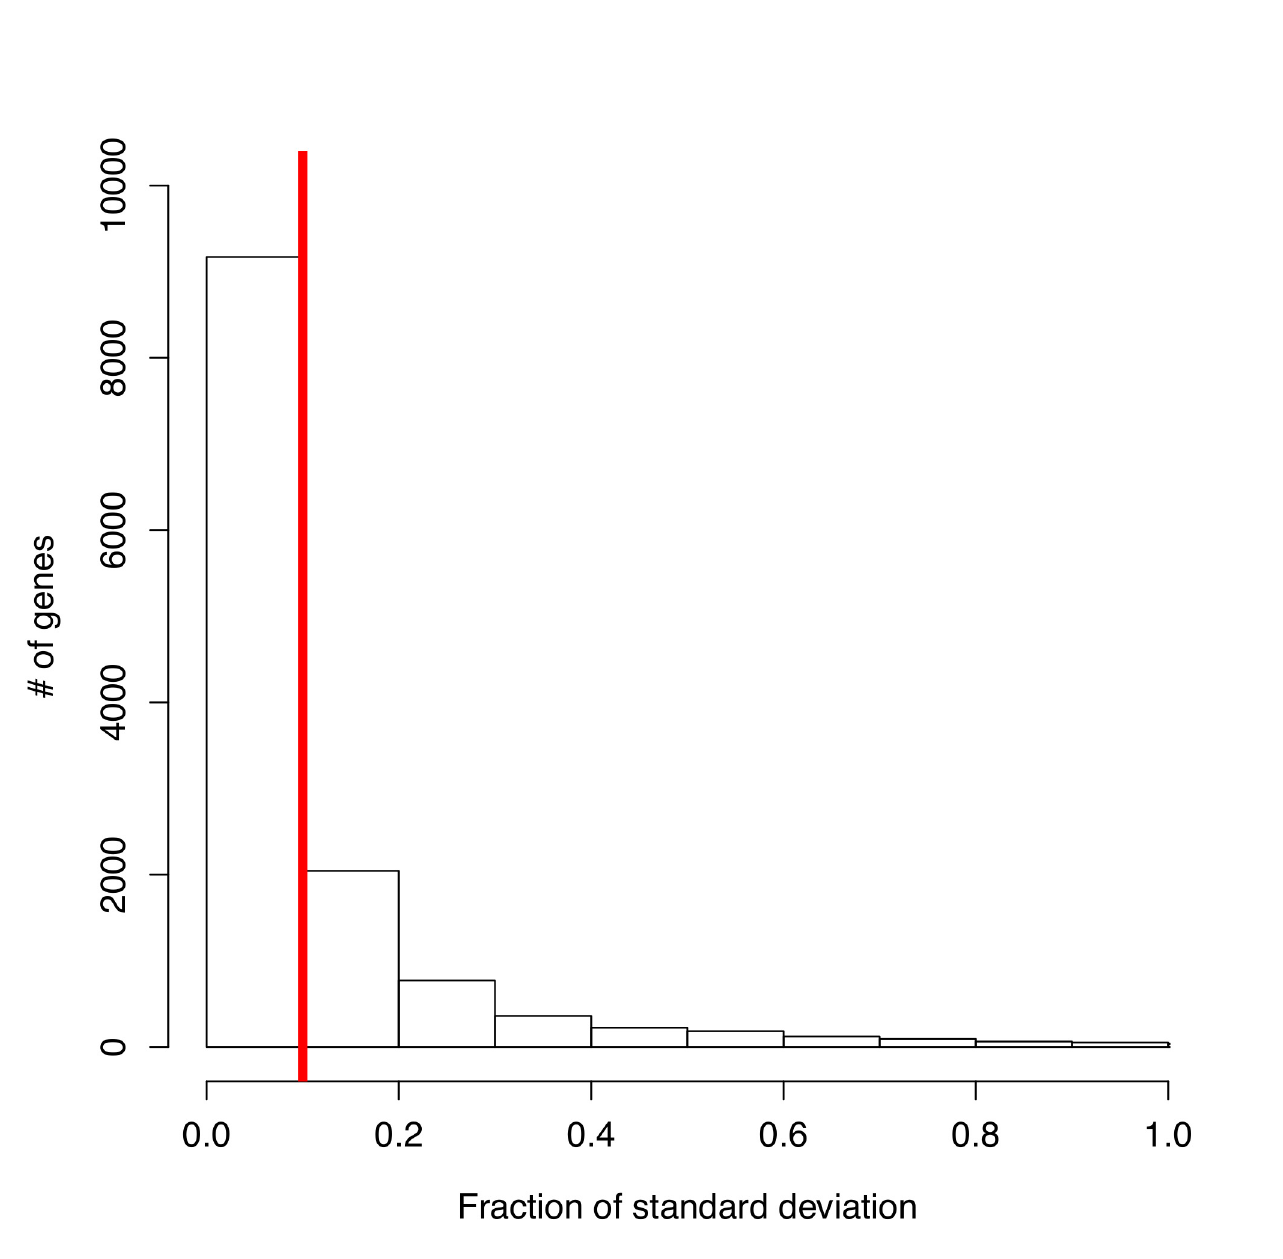
Fig 4. Distribution of standard deviation of gene expression. The vertical red line indicates the selection implemented on the data. Only the genes to right of the red line for further analysis have been